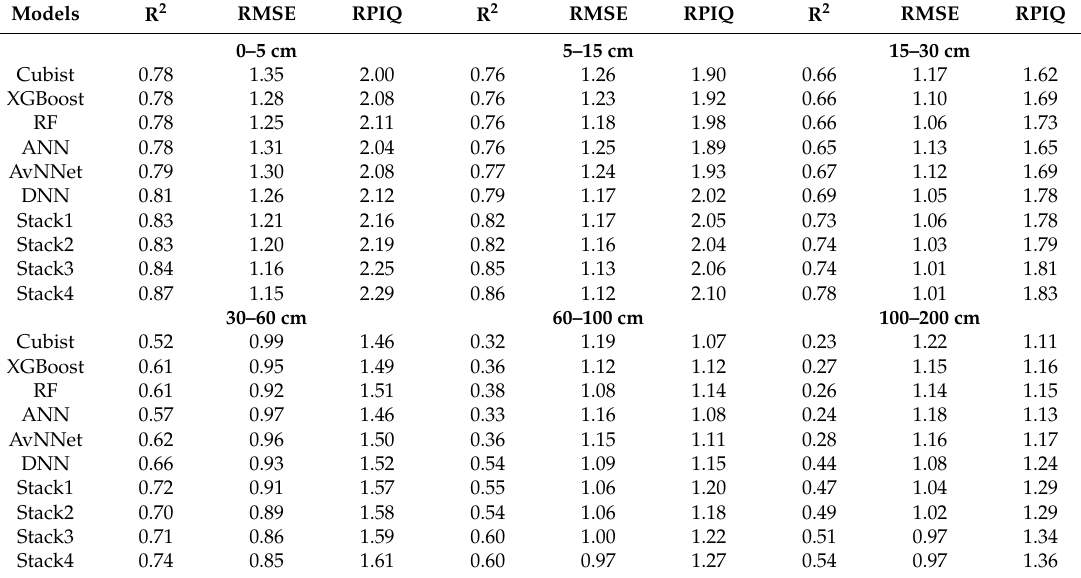
R 2 : coe ffi cient of determination; RMSE: root mean square error; RPIQ: Ratio of Performance to Interquartile distance; Stack: refers to Figure